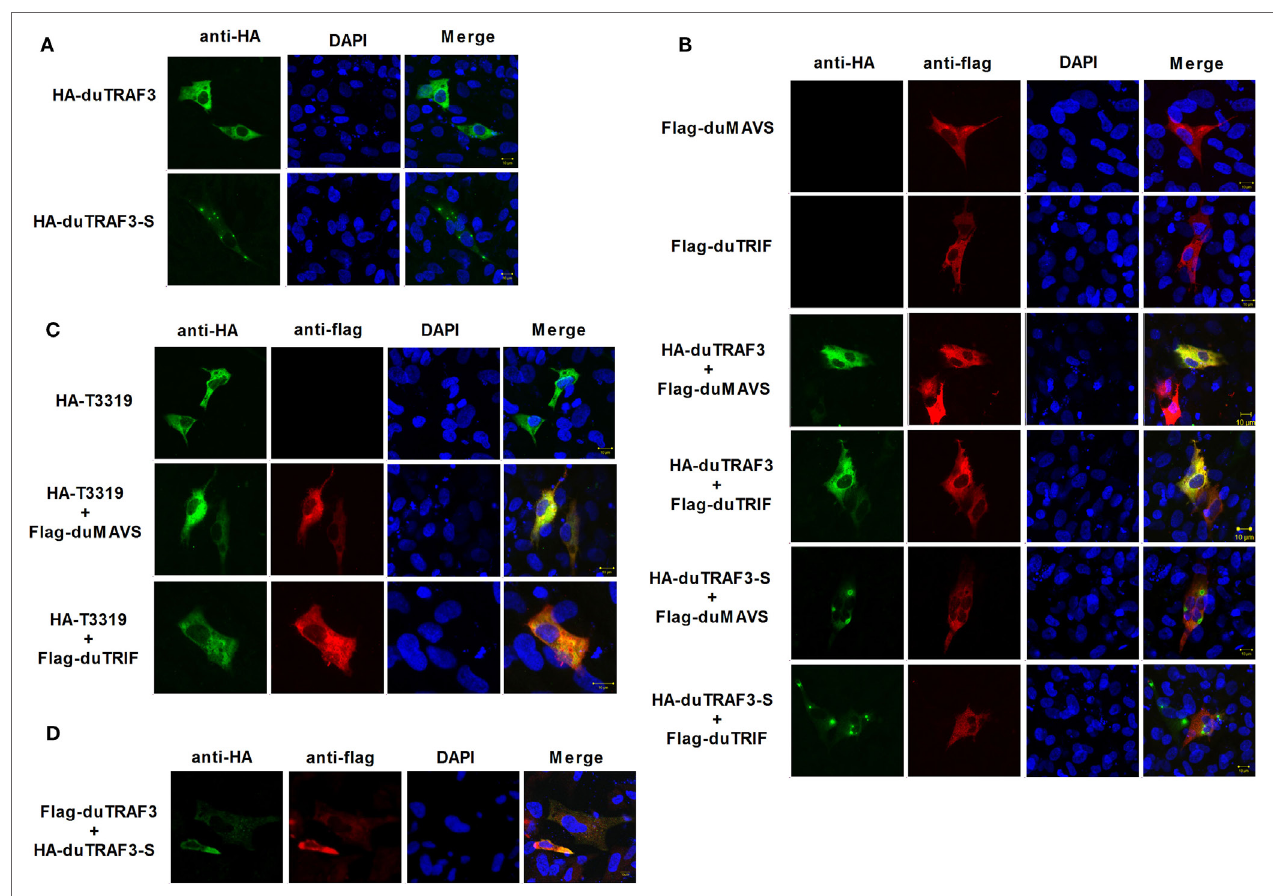
FigUre 8 | duMAVS or duTRIF colocalizes with duck TRAF3 (duTRAF3) or TRAF domain of duTRAF3 in the cytoplasm, but not spliced isoform of duTRAF3 (duTRAf3-S). (a) Duck embryo fibroblasts (DEFs) seeded in 12-well plates were transiently transfected individually with expression plasmids for HA-duTRAF3 or HA-duTRAF3-S for 24 h, and cells were then fixed and stained with antibody against the HA tag. Subsequently, cells were treated with FITC-conjugated goat anti-mouse secondary antibody and with 4 ′ ,6-diamidino-2-phenylindole (DAPI). (B) DEFs were transfected with Flag-duMAVS or Flag-duTRIF and HA-duTRAF3 or HA-duTRAF3-S. (c) DEFs transiently transfected with HA-T3319 and Flag-duMAVS or Flag-duTRIF. (D) DEFs transiently transfected with HA-duTRAF3-S and Flag-duTRAF3. Twenty-four hours after transfection, cells were fixed with 4% paraformaldehyde and stained with anti-HA or anti-Flag antibody. Secondary antibodies conjugated to Cy3 or FITC were used to visualize the stained Flag-tagged and HA-tagged proteins, respectively. DAPI show the nuclei of cells. Fluorescence was examined with a Zeiss LSM 510 Meta confocal